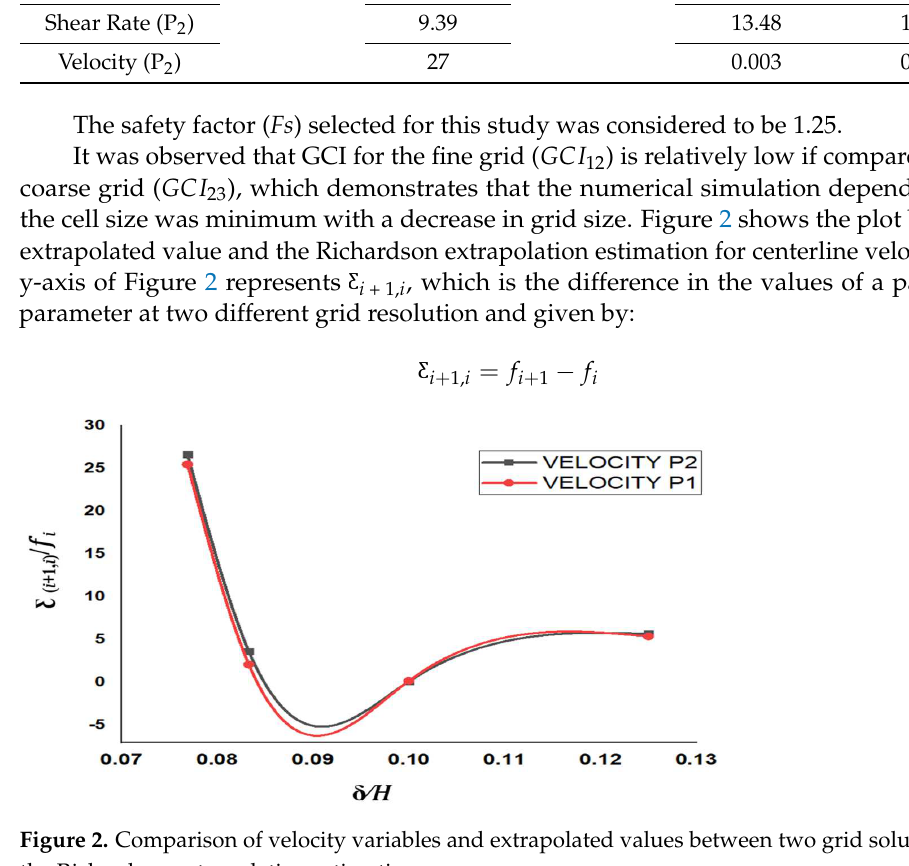
Figure 2. Comparison of velocity variables and extrapolated values between two grid solutions and the Richardson extrapolation estimation.